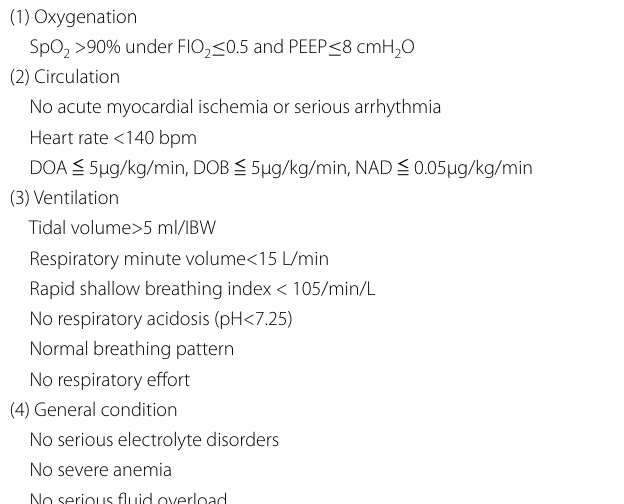
SBT spontaneous breathing trial, DOA dopamine, DOB dobutamine, NAD noradrenaline, IBW ideal body